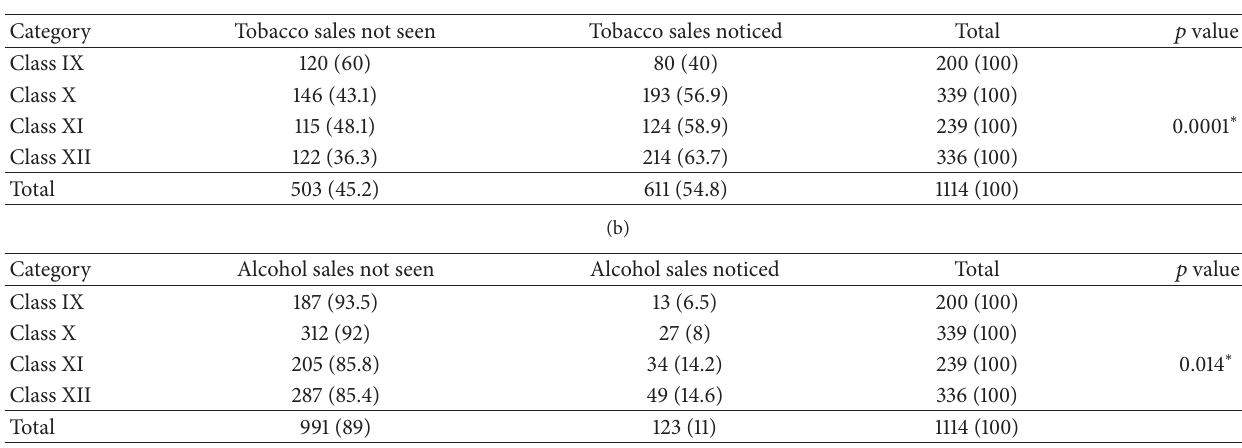
Table 3: Sale of tobacco and alcohol near schools noticed.